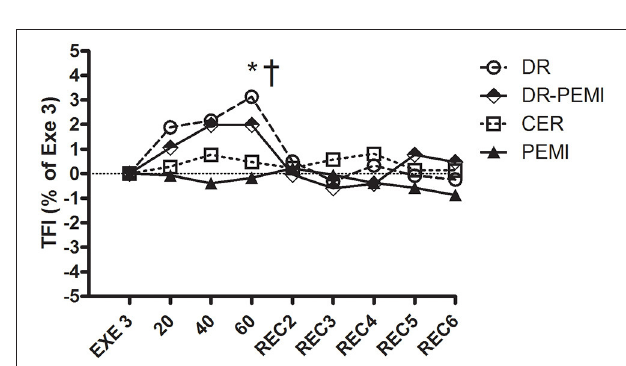
FIGURE 5 | SV/VET time courses during all four tests. Values are means ± SD percentages of the end of handgrip (EXE3). * = P < 0.05 vs. EXE3. † = P < 0.05 vs. PEMI.